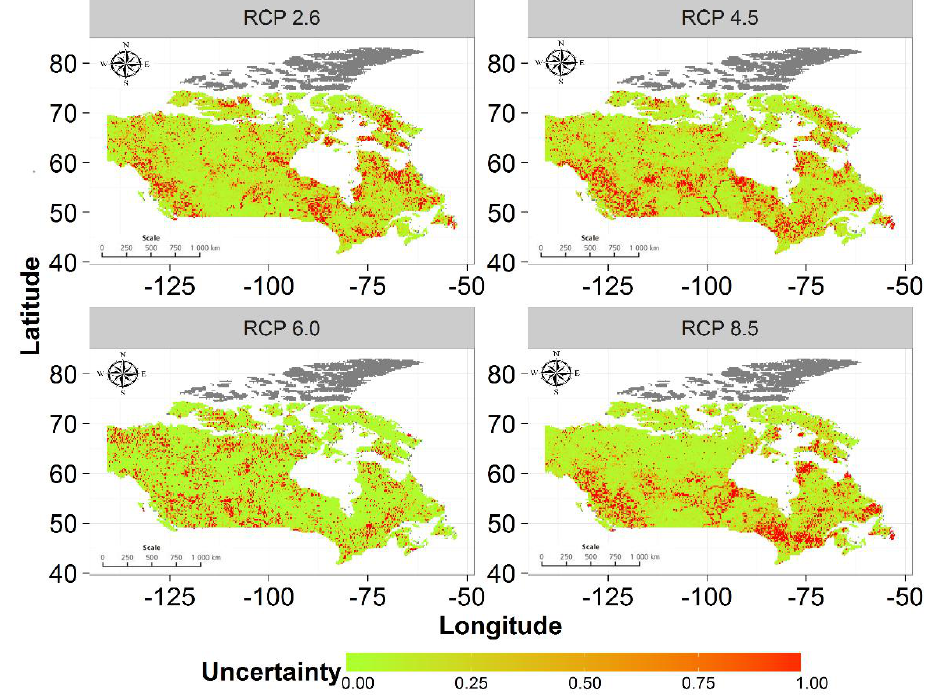
Figure 6. Normalized values of uncertainties obtained for different regions of Canada for 100-year return period flooding event when GCM projections are aggregated using a GCM median